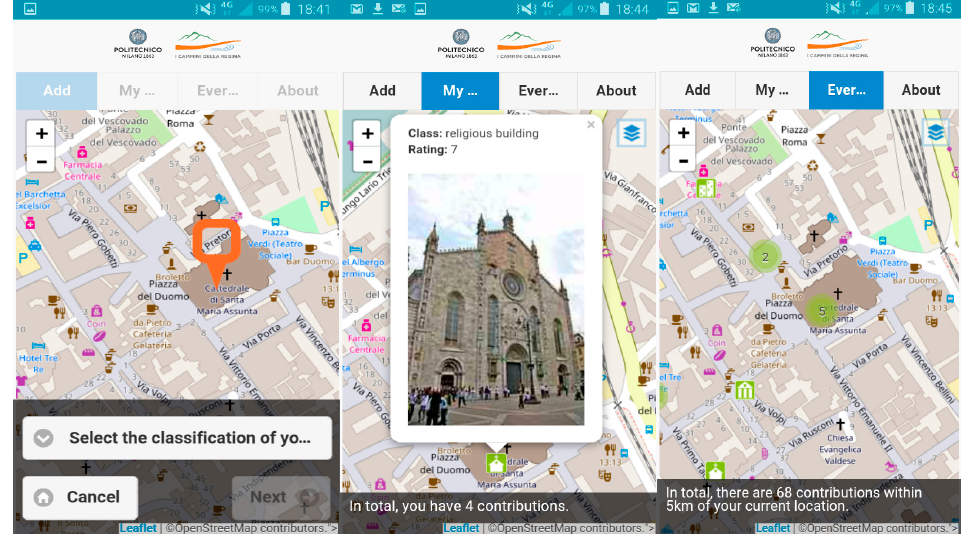
Figure 4. The Via Regina app: an example of participatory sensing. Users, after sensing, can view their own data (My Map) as well as that contributed by others (Everyone).